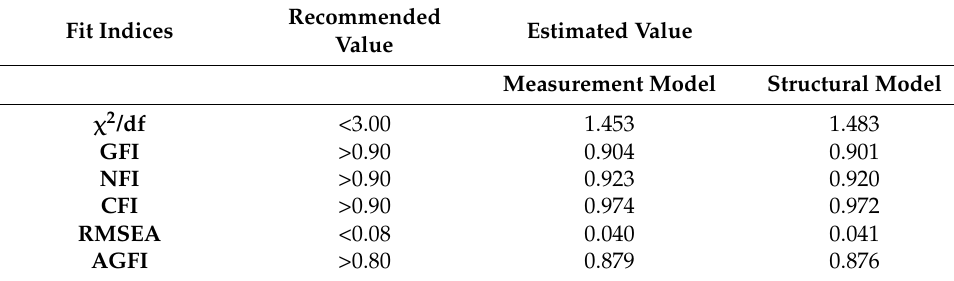
Table 5. Fit model indices